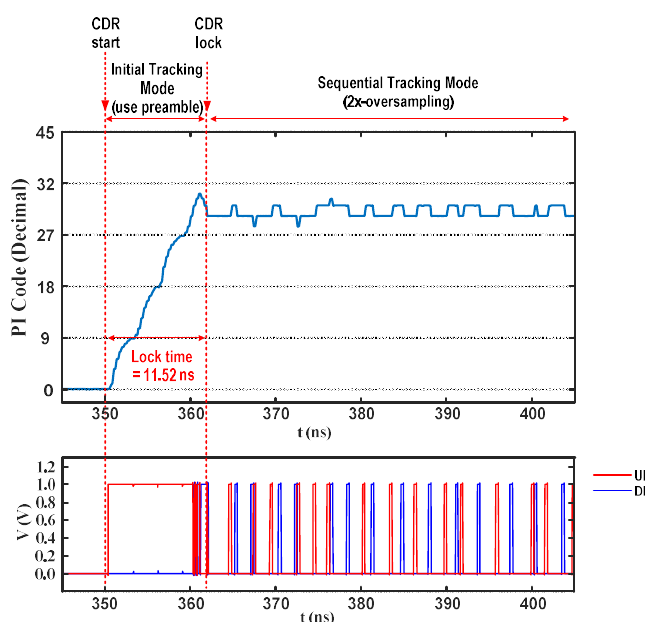
Figure 11. Locking process of the proposed 25 Gb/s quarter-rate digital CDR.